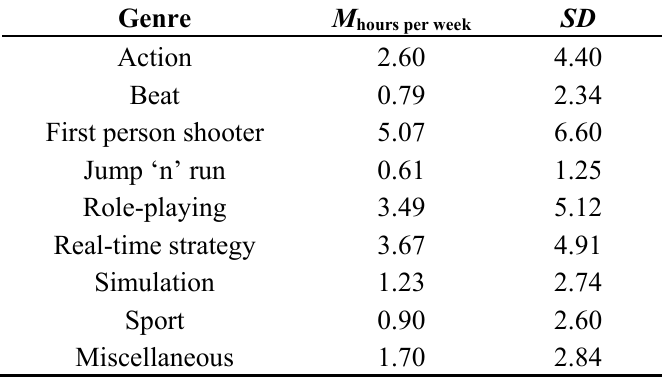
Table 1. Means and SD for playing time per genre in hours per